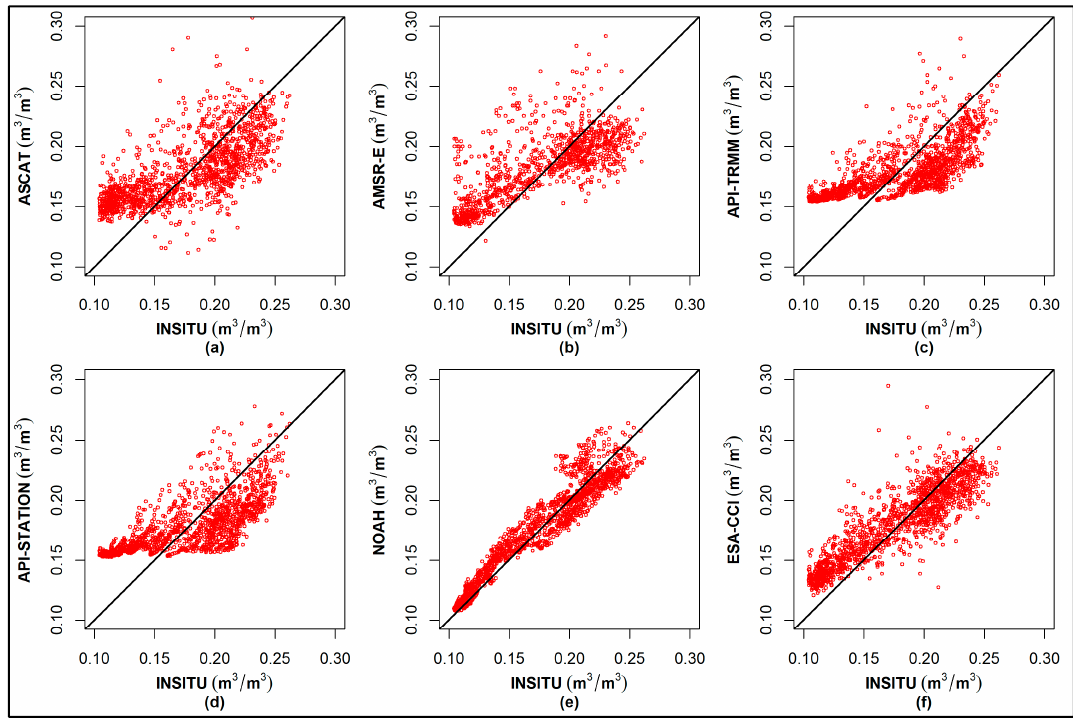
Figure 6. Scatter plot of each soil moisture product